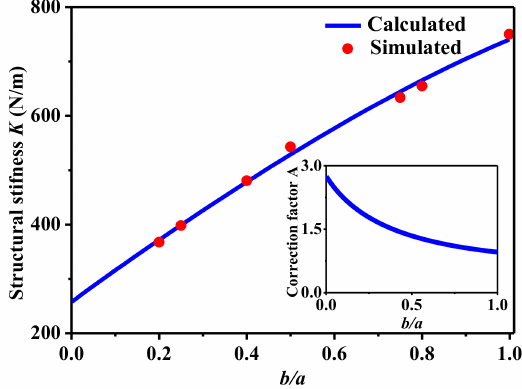
Figure 2. Sti ff ness and correction factor for the basic